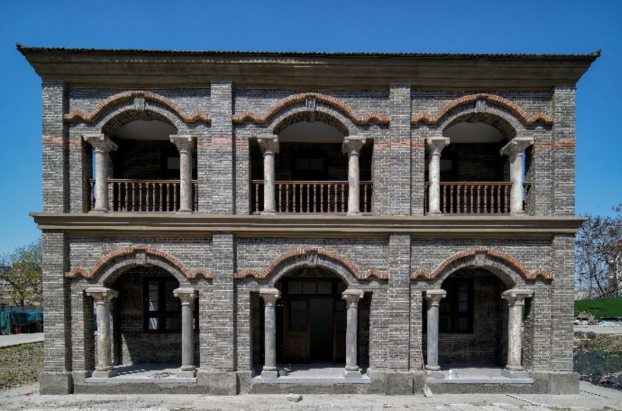
Figure 17. South facade of the Priest’s